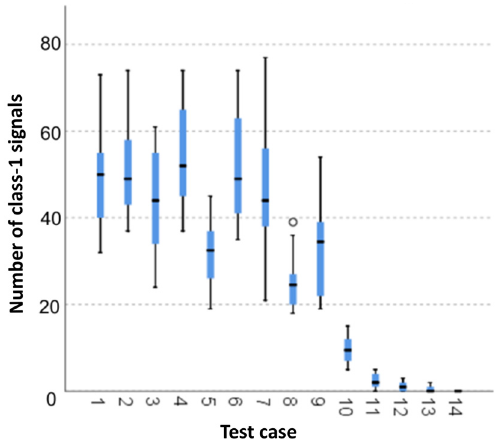
Figure 2. Graphic presentation of the Kruskal–Wallis test results for independent samples: number of class-1